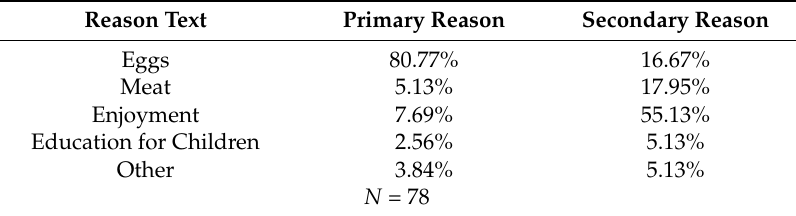
Table 1. Primary and secondary rationales of private owners for keeping backyard chicken